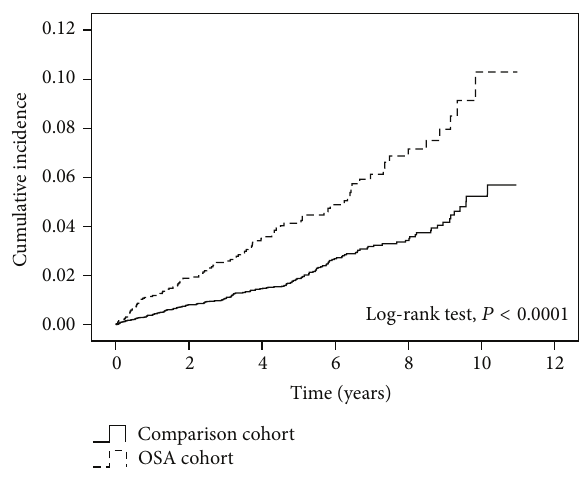
Figure 1: Cumulative incidence rates of glaucoma in study popula-